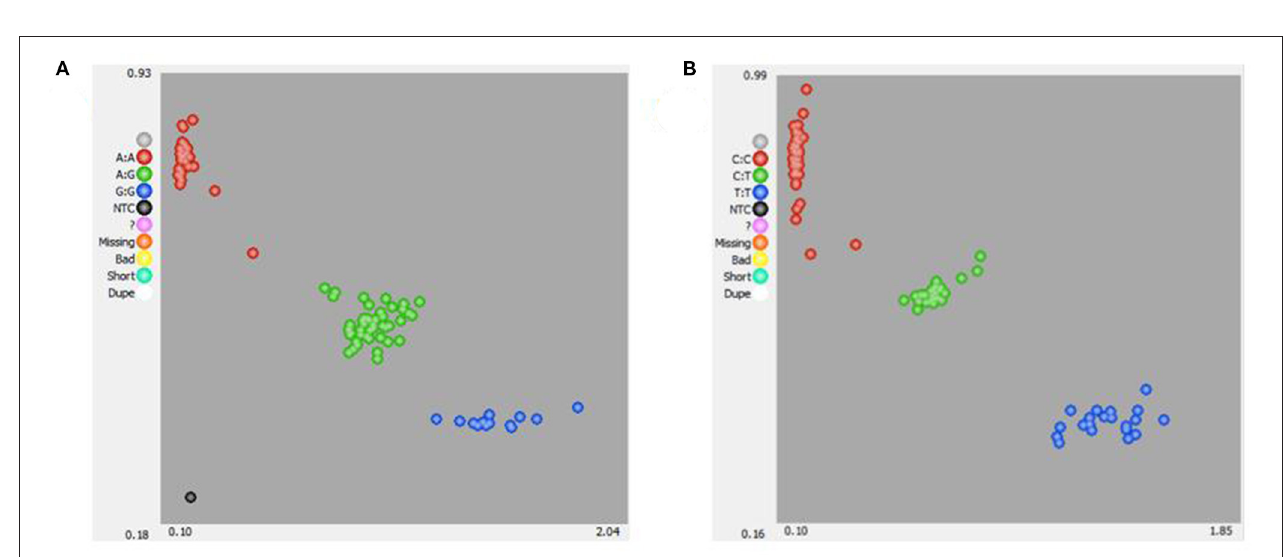
FIGURE 3 | KASPar-based single nucleotide polymorphism (SNP) genotyping of sheep TRAPPC9 g.57654A > G (A) and BAIAP2 g.460C > T (B) .